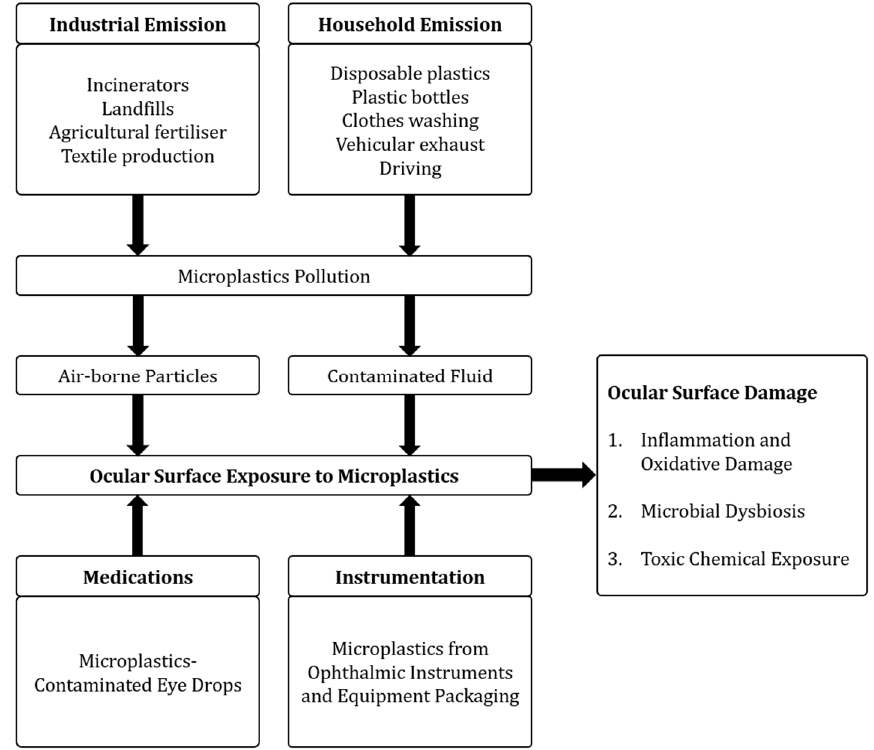
Figure 1. Sources of microplastics exposure.